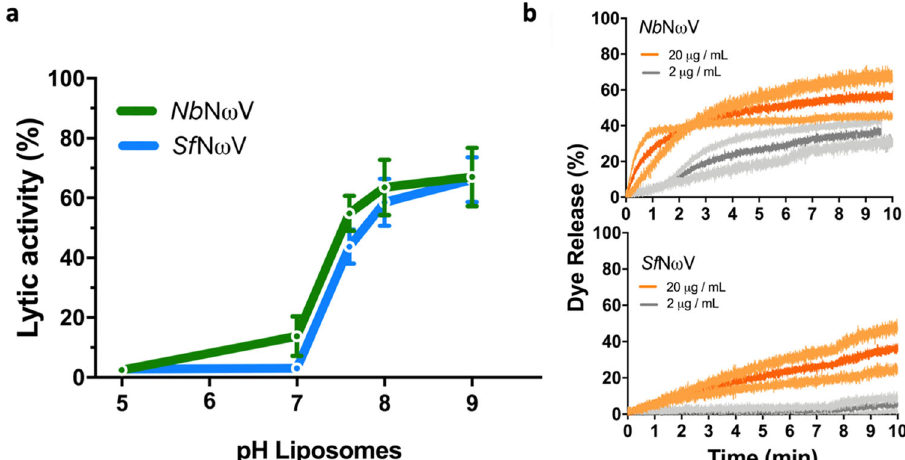
Fig. 3 Membrane lytic activity of N ω V VLPs produced in plants and insect cells. a Lytic activity of mature N ω V VLPs expressed in plants (green line) and insect cells (blue line) against DOPC liposomes under different pH conditions (from 5.0 to 9.0). End point values were measured after 10-min incubations with liposome preparations. Standard deviations from at least two experiments are shown as error bars. The raw data for the construction of the curves is given in Supplementary Data 2. b Initial kinetics of liposome dye release at pH 7.6 induced by mature N ω V VLPs produced in plants (top panel) or insect cells (bottom panel). In each case, two N ω V VLP concentrations were tested, 2 μ g/mL (grey lines) and 20 μ g/mL (orange lines). Standard deviations from at least two experiments are shown as lighter shades of each in the capsid. The modelling was aided by the equivalence of the density in the terminal regions in all four subunits of the the icosahedral asymmetric unit. The N-terminal residues procapsid, which is not the case in the capsid (Fig. 6). Treating (44 – 116) and C-terminal residues (533 – 644), poorly de fi ned in the four subunit models as equivalent reduced the parameters and the previous procapsid reconstruction 9 , were modelled with approximate reference to the equivalent residues clearly de fi ned improved the con fi dence in the fi nal coordinates.